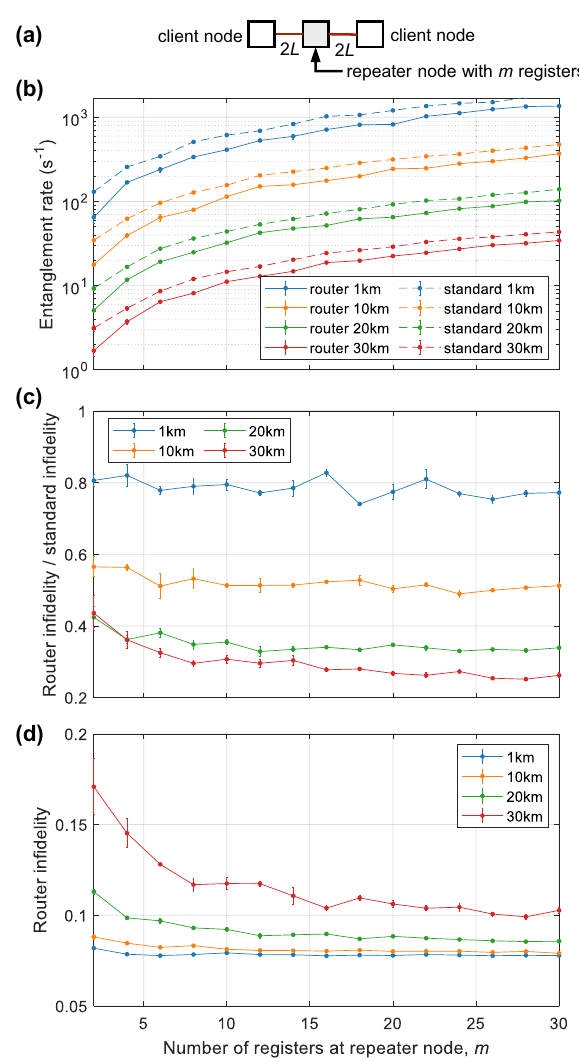
Fig. 4 Simulation results for different repeater con fi gurations. Each data point is the result of three independent simulations. The average rates and in fi delities are plotted, with the standard error of the mean shown as the error bars. The lengths (1, 10, 20, 30 km) refer to the distance L between the repeater node and the detector station. a Link layer representation of the simulated one-repeater network. b Steady-state entanglement rate against m . As expected, the rate of entanglement generation increases with the number of repeater qubit registers ( m ), as expected. The entanglement rate of the router architecture is slightly lower than the entanglement rate of the standard repeater, and the difference decreases as the size of the repeater increases. c Ratio of entanglement in fi delity against m . The fi delity of entanglement generated by the router is higher than that of the standard repeater for suf fi ciently large distances L . The fi delity of entanglement generated by the router improves as m increases, whereas that of the standard repeater does not. This causes the in fi delity ratio to decrease as m increases. d Router in fi delity against m . As m increases, the router in fi delity approaches a channel-loss-invariant value that only depends on local gate fi delities and the round-trip travel discussed below, using experimentally realized values reported in the literature (see Supplementary Note 1 for details). Figure 4b plots the entanglement distribution rates for both repeater architectures for various link distances as a function of the number of qubit registers m at the repeater node. For the routerless case, the rate scales linearly with m since the qubit